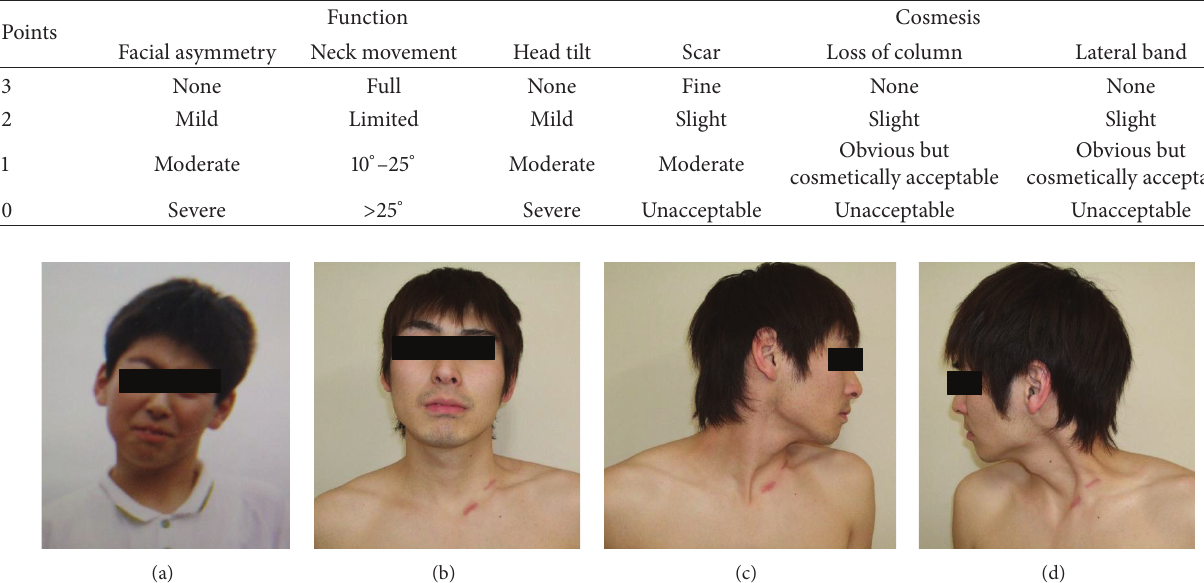
Figure 1: A 28-year-old man with muscular torticollis. (a) Preoperative photograph showing severe head tilt. (b) Postoperative photograph taken 12 months after surgical release showing an excellent cosmetic result. (c and d) Postoperative photographs taken 12 months after surgical release showing range of motion in the